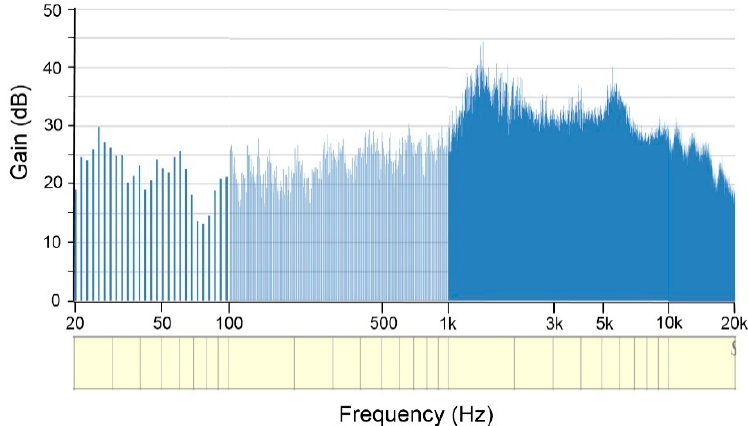
Figure 7. Transfer function of the acoustic test fixture shows the gain estimated from the data col- lected by the blast probe microphone.